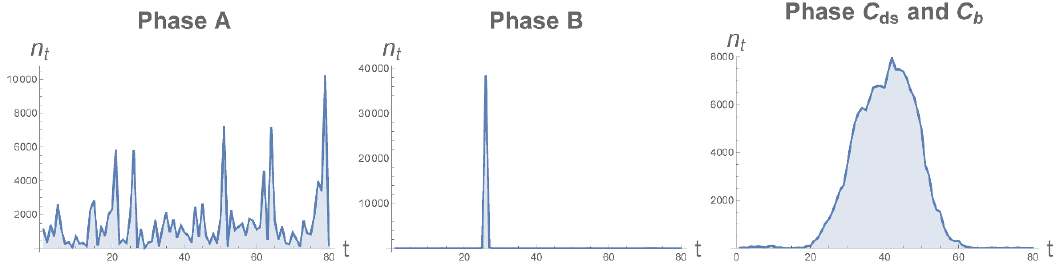
Figure 4 . Typical volume pro(cid:12)les n t (cid:17) N topology (cid:6) = S 3